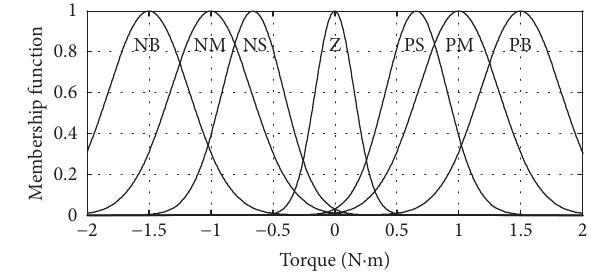
Figure 5: Fuzzy sets for output torque.